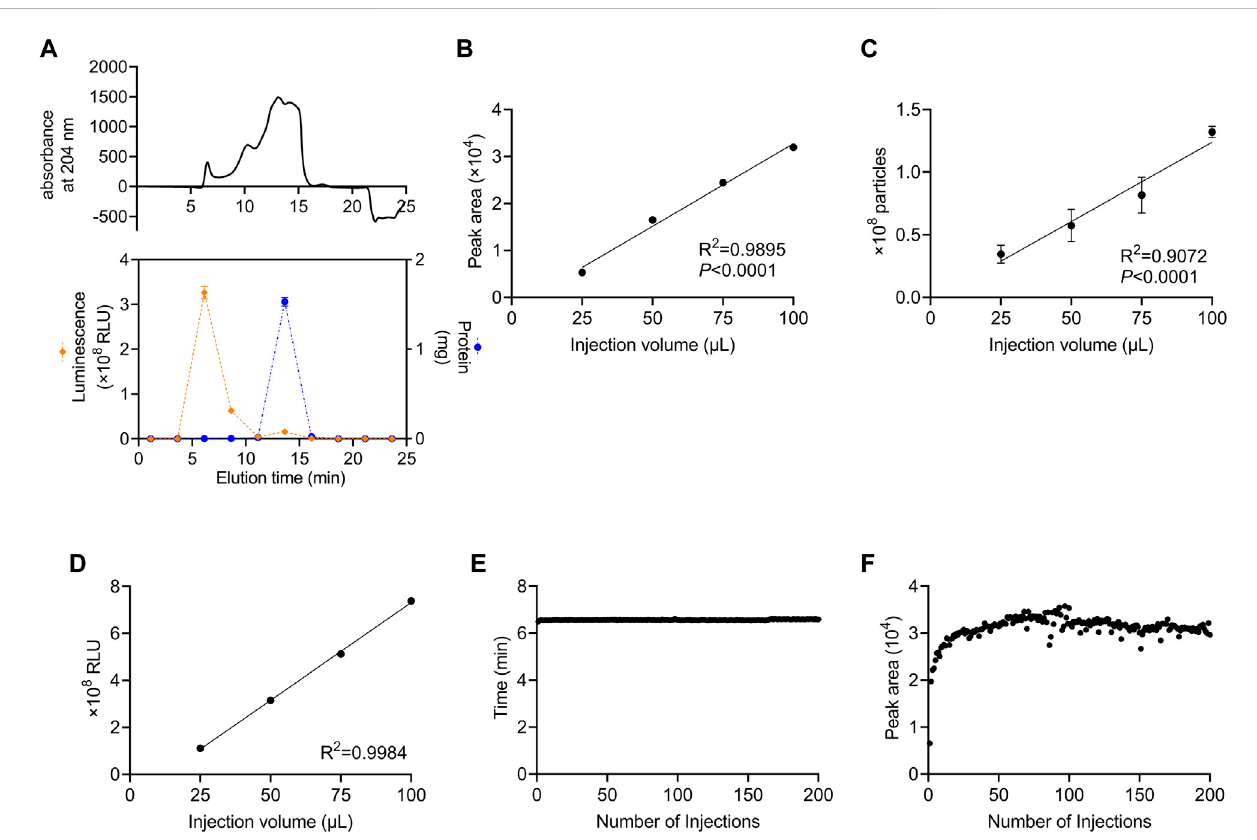
FIGURE 1 Stable recovery of sEVs derived from cultured cells using SEC (A) Isolation of sEVs from cell-cultured medium using the SEC system. Upper panel: the absorption of peptides bind at 204 nm. Lower panel: the Nanoluc luciferase intensity and the protein content of each fraction are represented by orange diamonds (left axis) and blue circles (right axis), respectively. (B) Correlation between the injection volume and the peak area of HT29-CD63-Nluc. The peak area was calculated from DAD measurements. (C) Correlation between the injection volume and the number of particles measured. The number of particleswasmeasuredbyNanoSight. (D) CorrelationbetweentheinjectionvolumeandNanolucluciferaseintensity.Theluminescencewasmeasuredwitha luminometer. (E) The time of the peaks from 200 injections. (F) The peak area for 200 injections. (A – D) data are presented as the means ± SD from triplicate